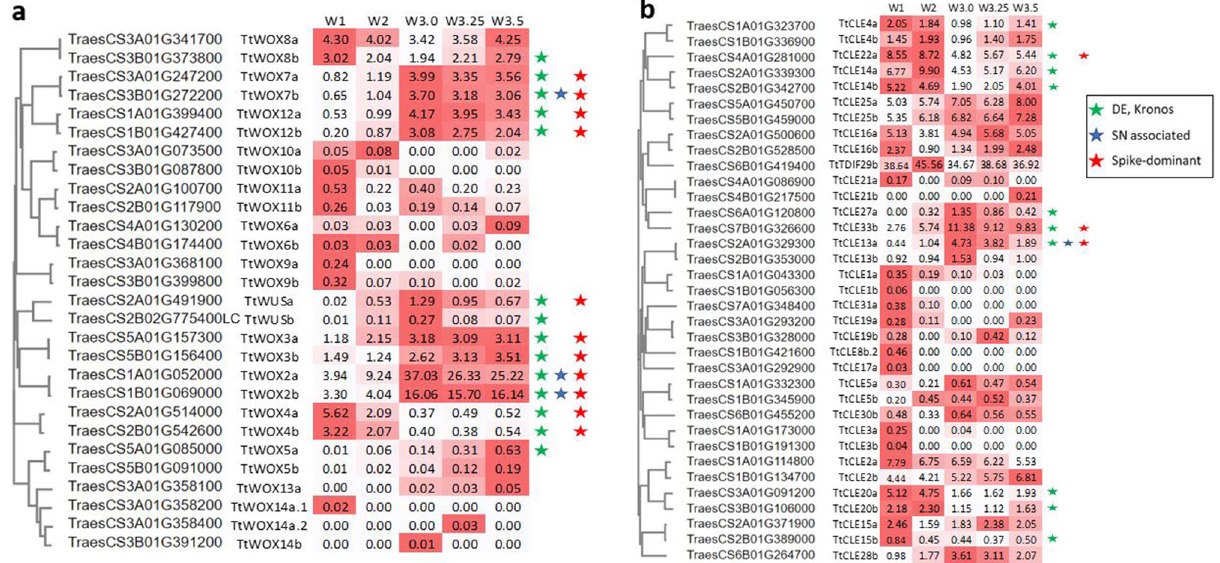
Figure 5. Expression profiles of WOX TFs ( a ) and CLE peptides ( b ) during wheat inflorescence development. Stars indicate additional evidence of a possible role in spike regulation (green = differential expression in ‘Kronos’ inflorescence, blue = associated with variation in spikelet number, red = spike-dominant expression profile). Heatmaps show expression (TPM) relative to each gene’s minimum and maximum expression. Only genes with TPM ≥ 0.01 are